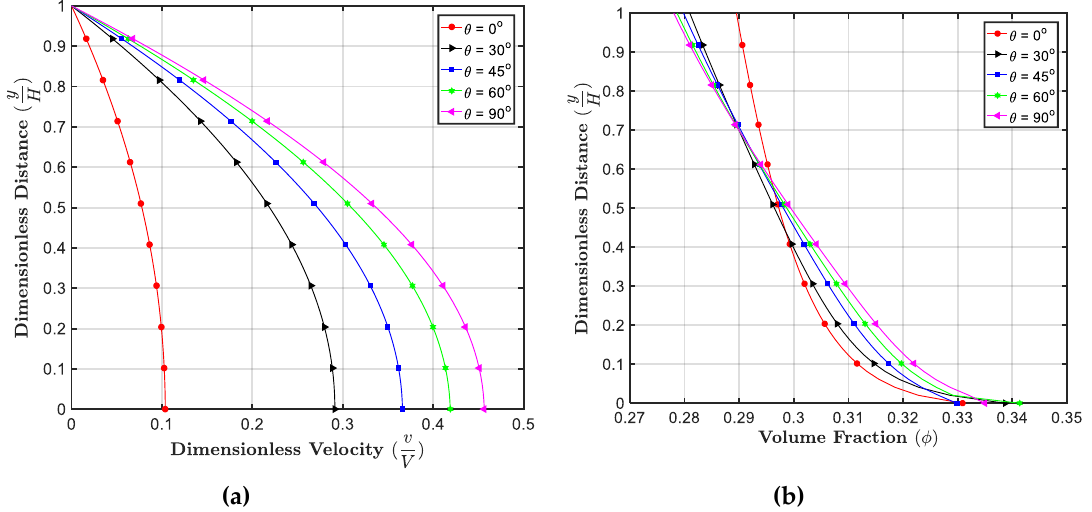
Figure 6. Distribution of the velocity for ( a ) 𝐾 𝑐 = 0.08; and the cement volume concentration for ( f ) 𝐾 𝑐 = 0.08. ( j ) 𝐾 𝑐 𝐾 𝜇